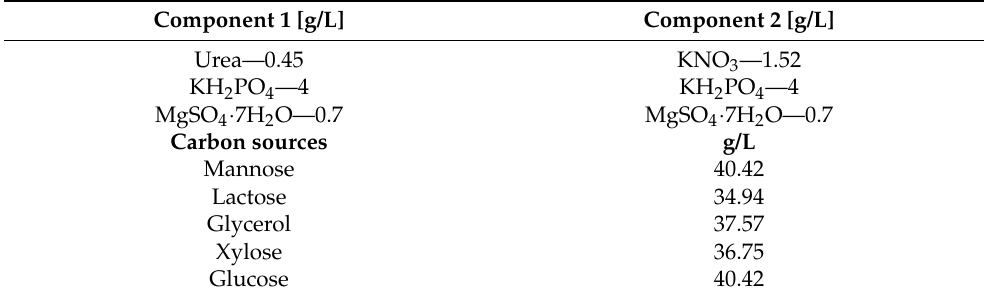
Table 2. Composition of the culture media with different carbon sources (C/N ratio